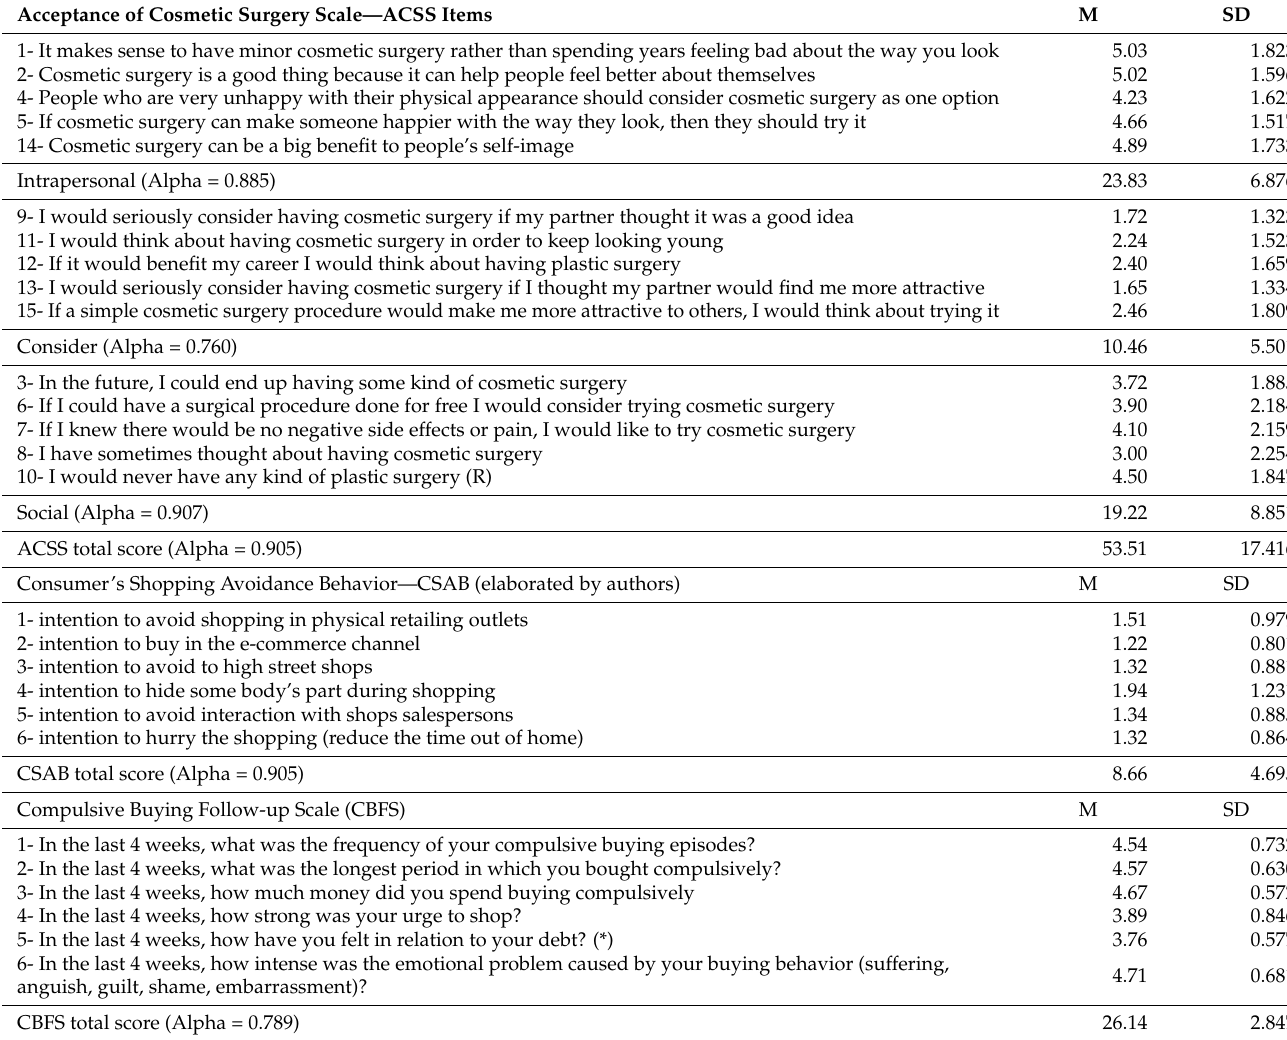
Table 2. Means and standard deviations of the items of the ACSS scale, Consumer’s Shopping Avoidance Behaviour (CSAB) and Compulsive Buying Follow-up Scale